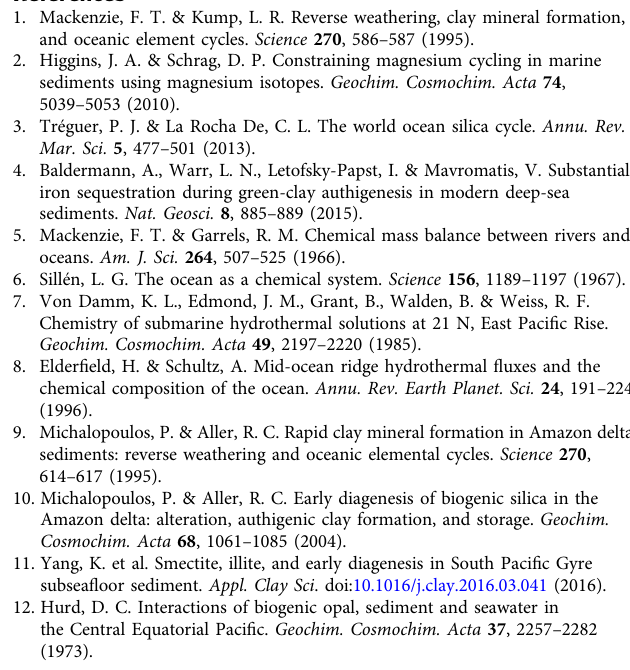
Table 1 of this study. Any additional data may be obtained from